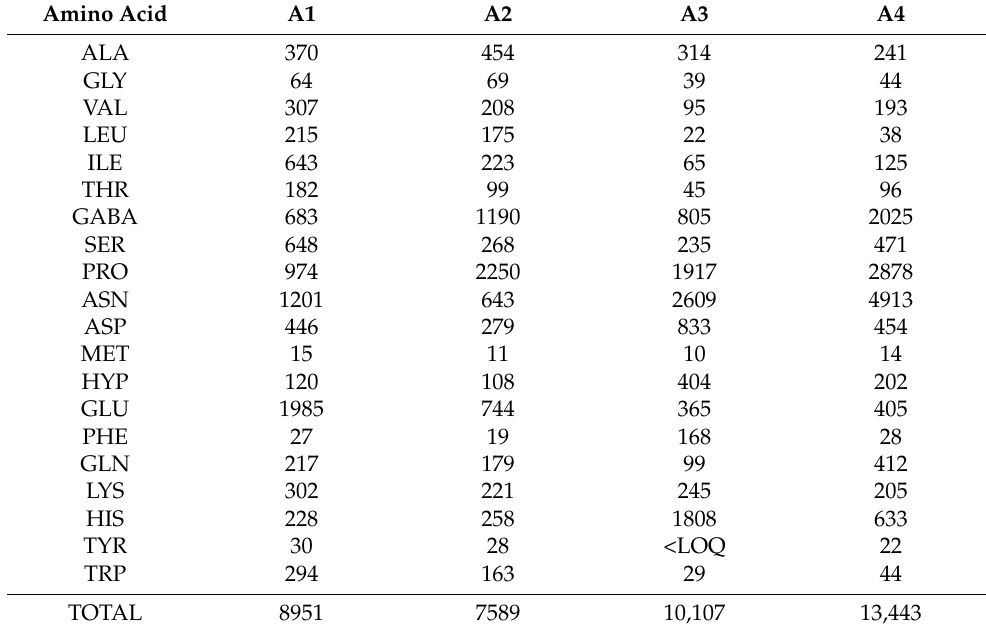
Table 7. Results (means of triplicate analyses (mg/kg; dry weight); %RSD < 15% in all cases) of the investigation of bee pollen samples from experimental apiaries